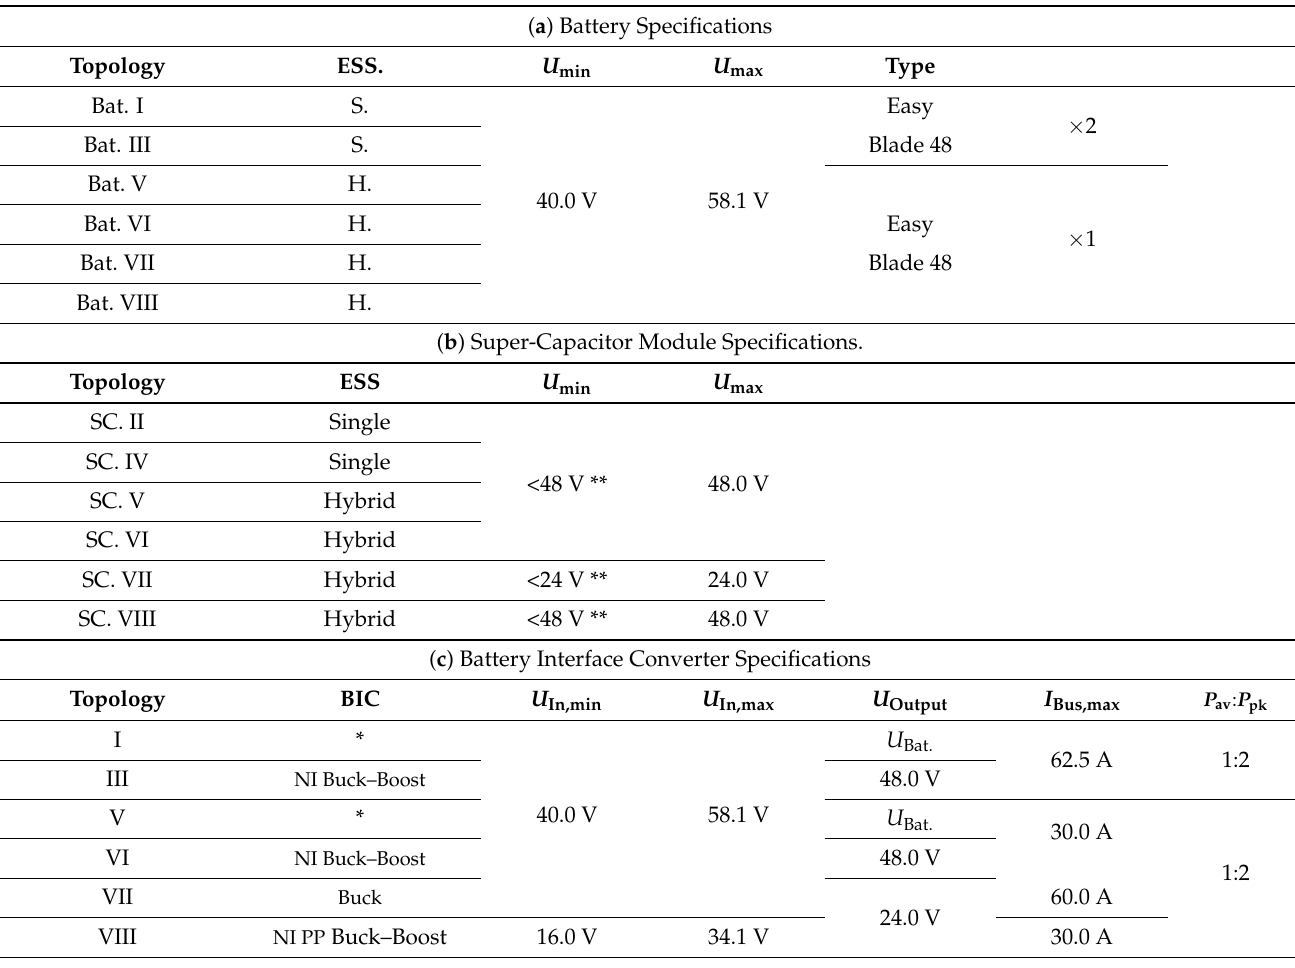
Figure 13. Considered Topologies with SCIC and BIC for the qualitative comparison: ( a ) Topology V withNI (non-inverting) Buck–Boost as SCIC; ( b ) Topology VI with Boost as SCIC and NI Buck–Boost as BIC; ( c ) Topology VIII with PP (partial power) Boost as SCIC and NI PP Buck–Boost as BIC. Table 16. Electrical specifications for the batteries, super-capacitors, BIC, and SCIC for all the topologies. ( a ) Battery